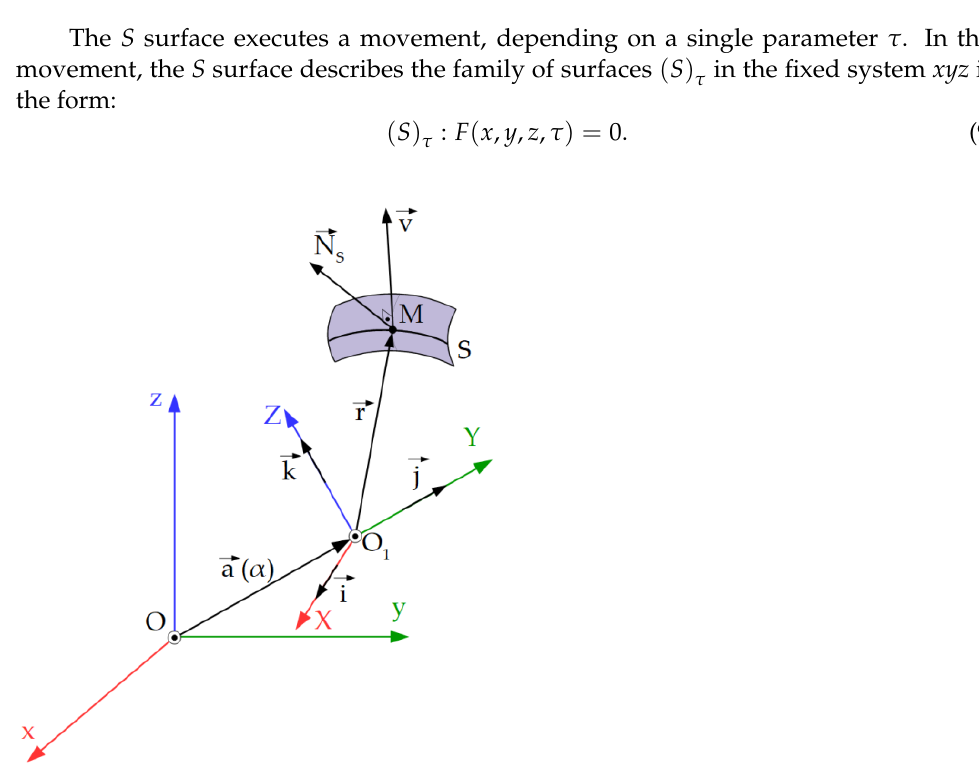
Figure 2. Reference systems: xyz —fixed reference system, XYZ —mobile reference system.